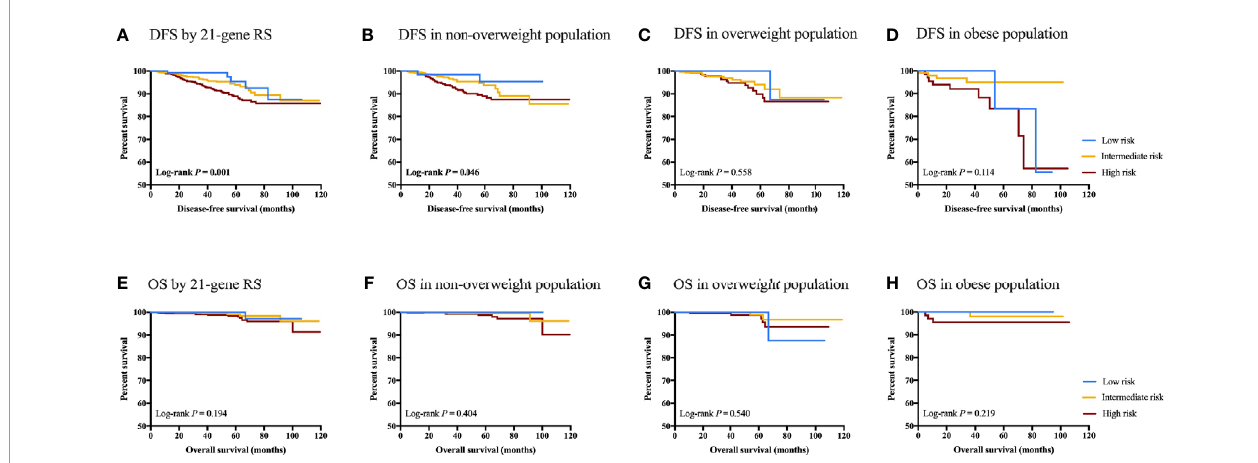
FIGURE 4 | Clinical outcomes of breast cancer patients with different RS category strati fi ed by BMI status. DFS in (A) DFS by 21-gene RS; (B) DFS in non- overweight population; (C) DFS in overweight population; (D) DFS in obese population; (E) OS by 21-genes RS; (F) OS in non-overweight population; (G) OS in overweight population; and (H) OS in obese population.